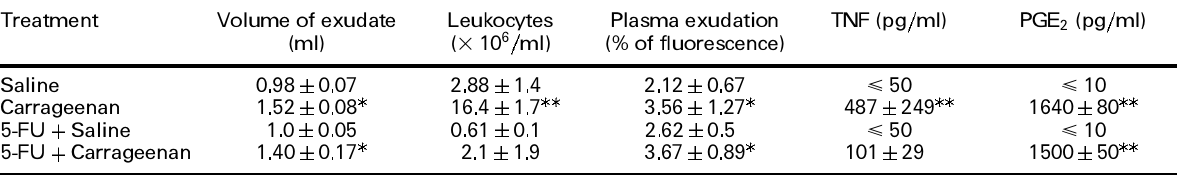
Table 2. Effect of 5-¯ uorouracil on the in¯ ammation induced by carrageenan in the mouse air-pouch Treatment Saline